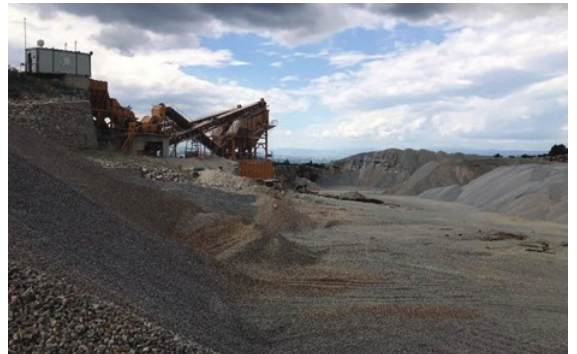
Figure 2. Aggregate stock